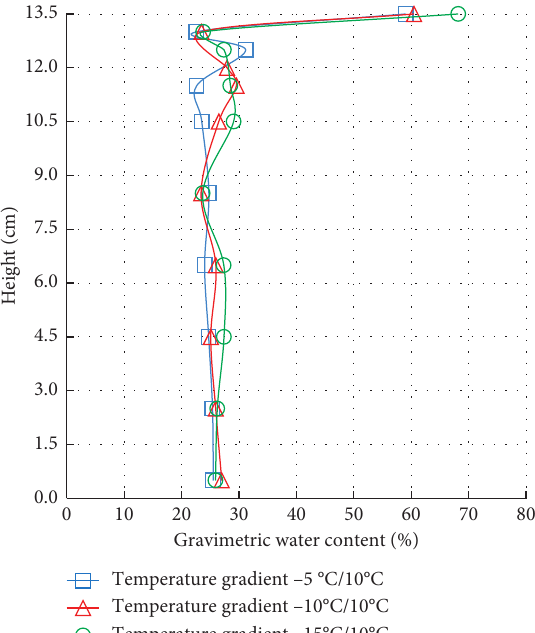
Figure 10: Water content distribution of different temperature gradients.